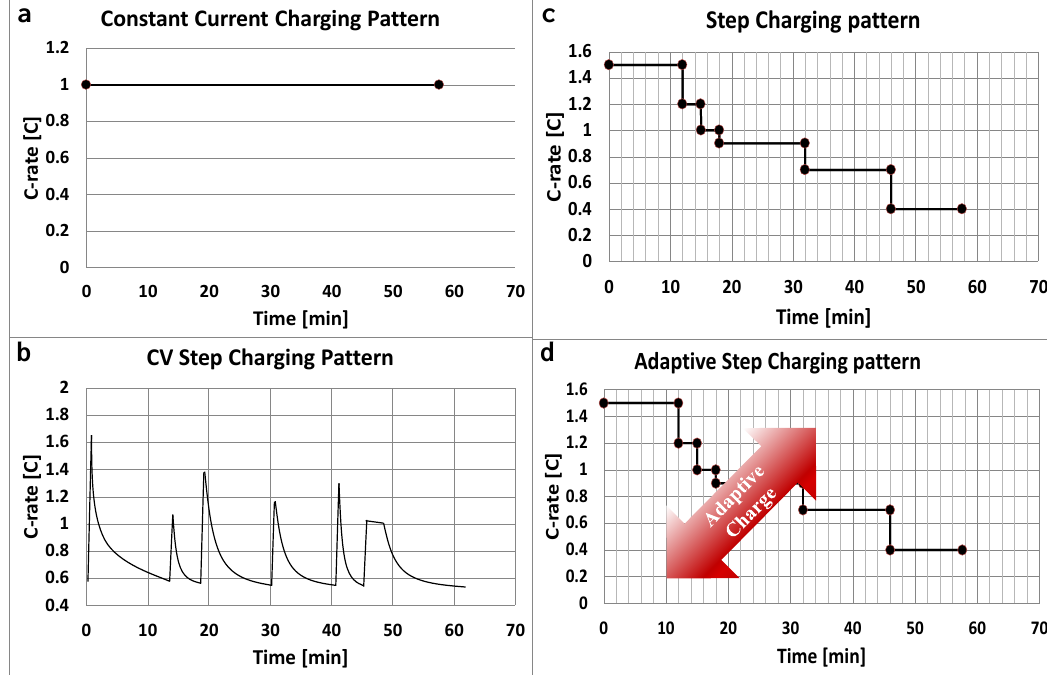
Figure 3. Rapid charging patterns: ( a ) A typical step charging pattern; ( b ) the novel constant current step rapid charging pattern; ( c ) a constant current charging pattern; and ( d ) an adaptive rapid charging pattern.